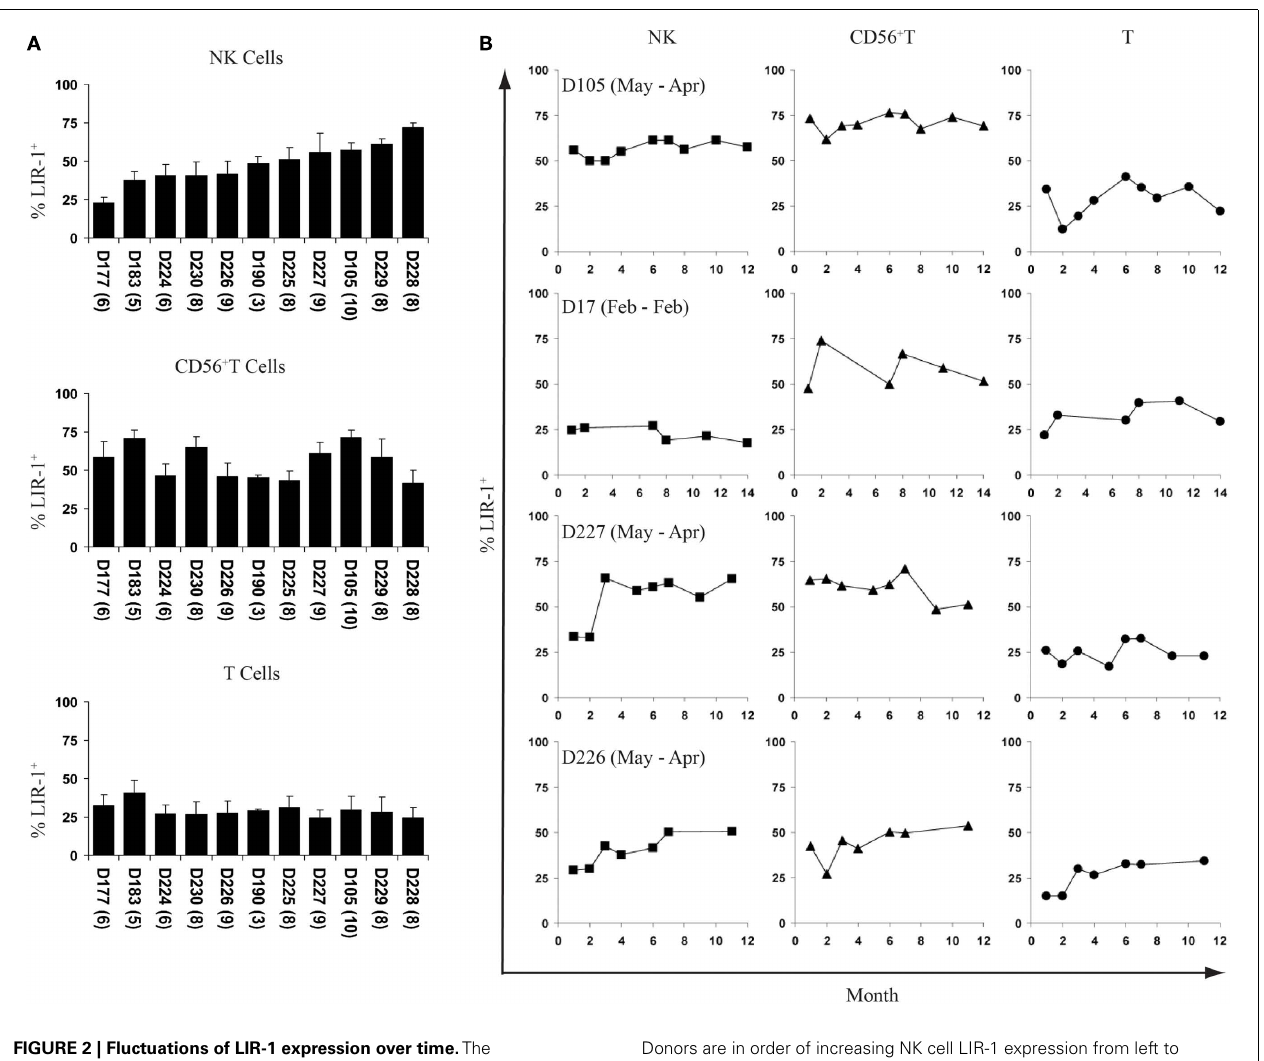
FIGURE 2 | Fluctuations of LIR-1 expression over time. The frequency of LIR-1 expression in the three lymphocyte subsets were examined on ex vivo PBMC by flow cytometry as depicted in Figure 1 for the panel of donors. (A) The average frequency of LIR-1 + cells for each subset was calculated for each donor for all time points collected.